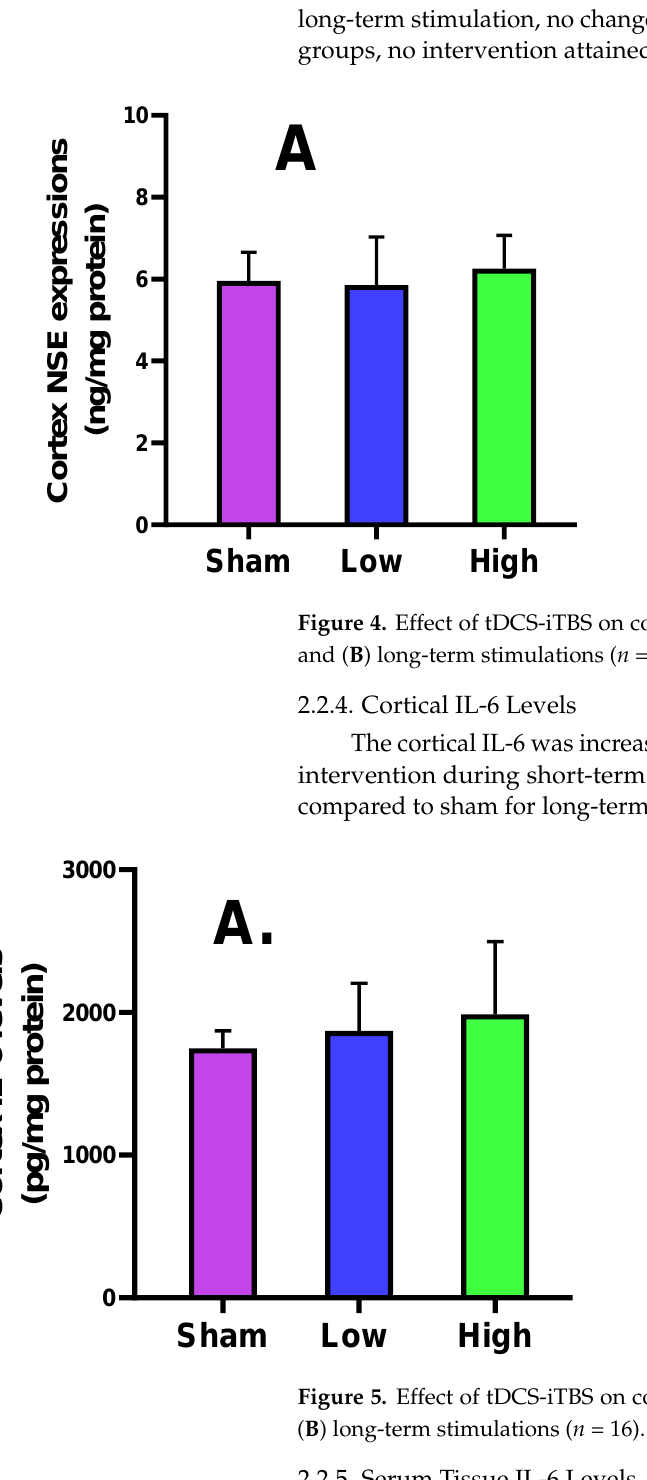
Figure 5. Effect of tDCS-iTBS on cortical IL-6 levels (pg/mg protein): ( A ) short-term ( n = 15) and ( B ) long-term stimulations ( n = 16).